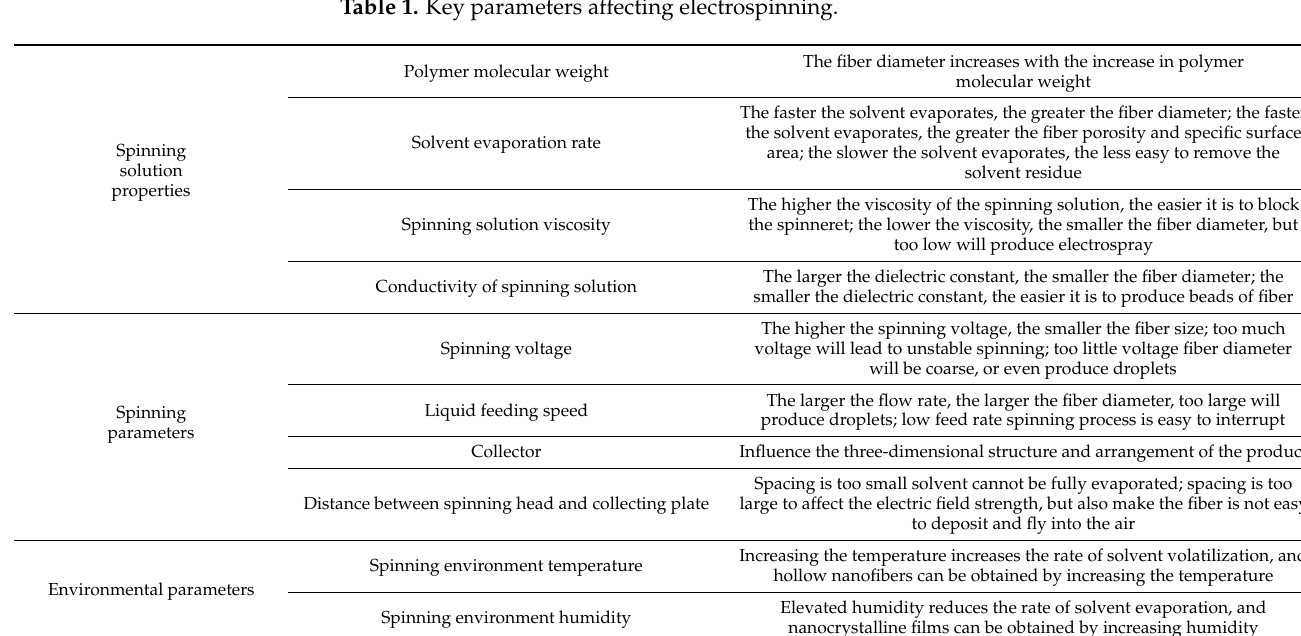
Table 1. Key parameters affecting